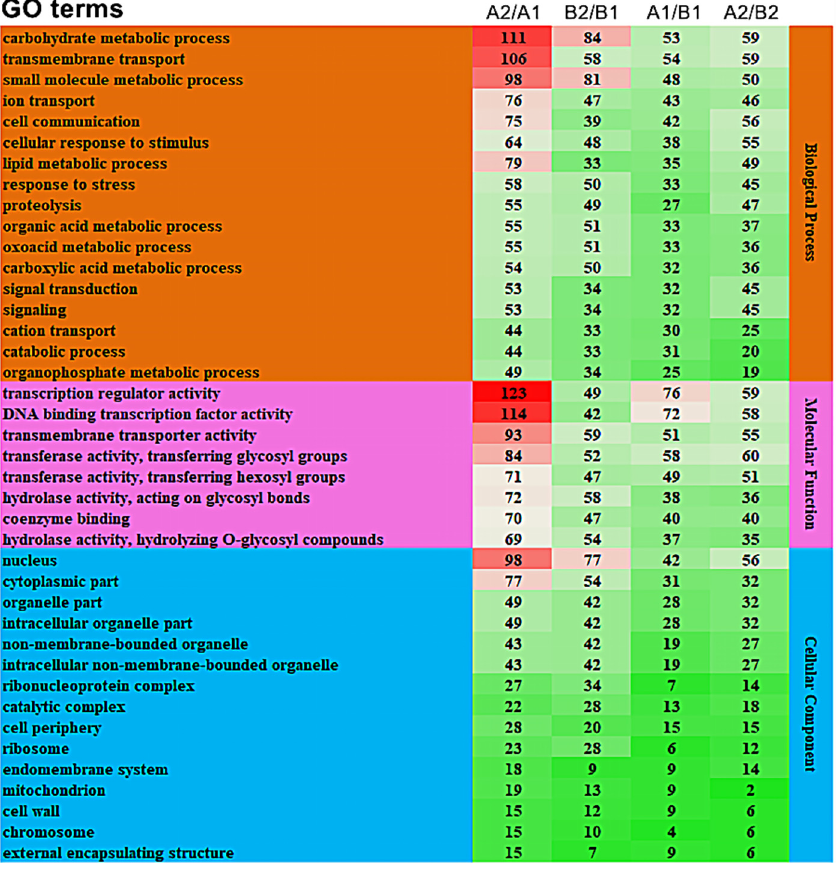
Figure 5. GO analysis of differentially expressed genes. Annotation: The numbers in the diagram represent the number of genes in the enrichment. The higher the number, the redder the color; the lower the number, the greener the color. A1/B1 means A1 compared to B1; A2/B2 means A2 compared to B2; B2/B1 means B2 compared to B1; A2/A1 means A2 compared to A1.